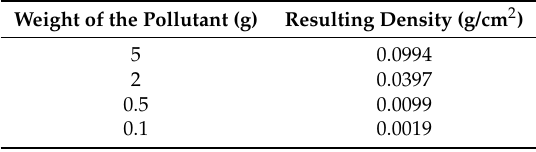
Table 4. Density of the pollutants in the